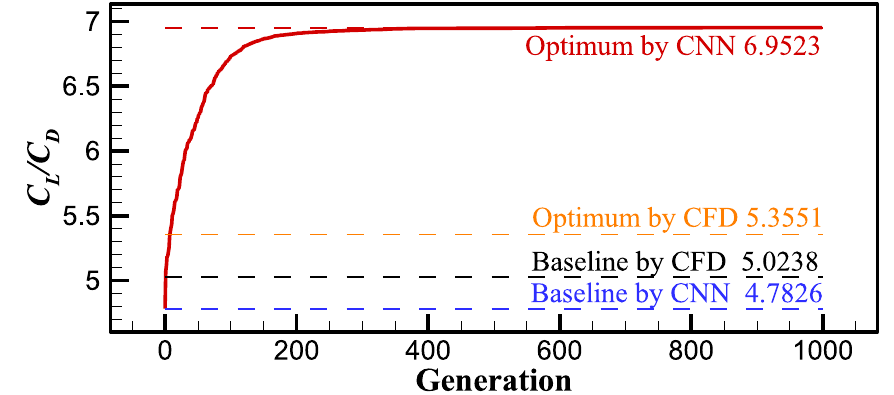
Fig. 28 Convergence history of aerodynamic shape optimization for the wing (optimization case 2)